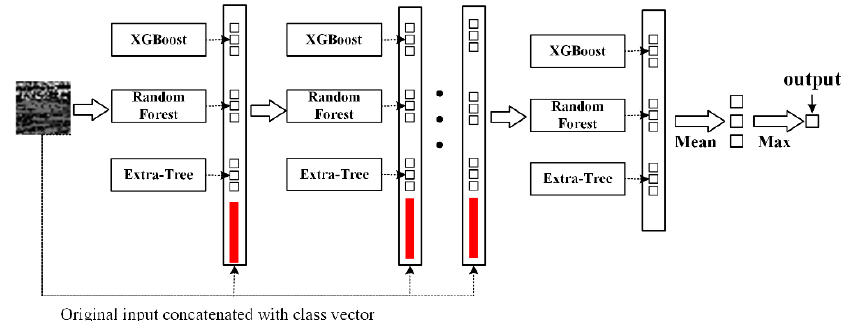
Figure 6. The structure of CaForest.